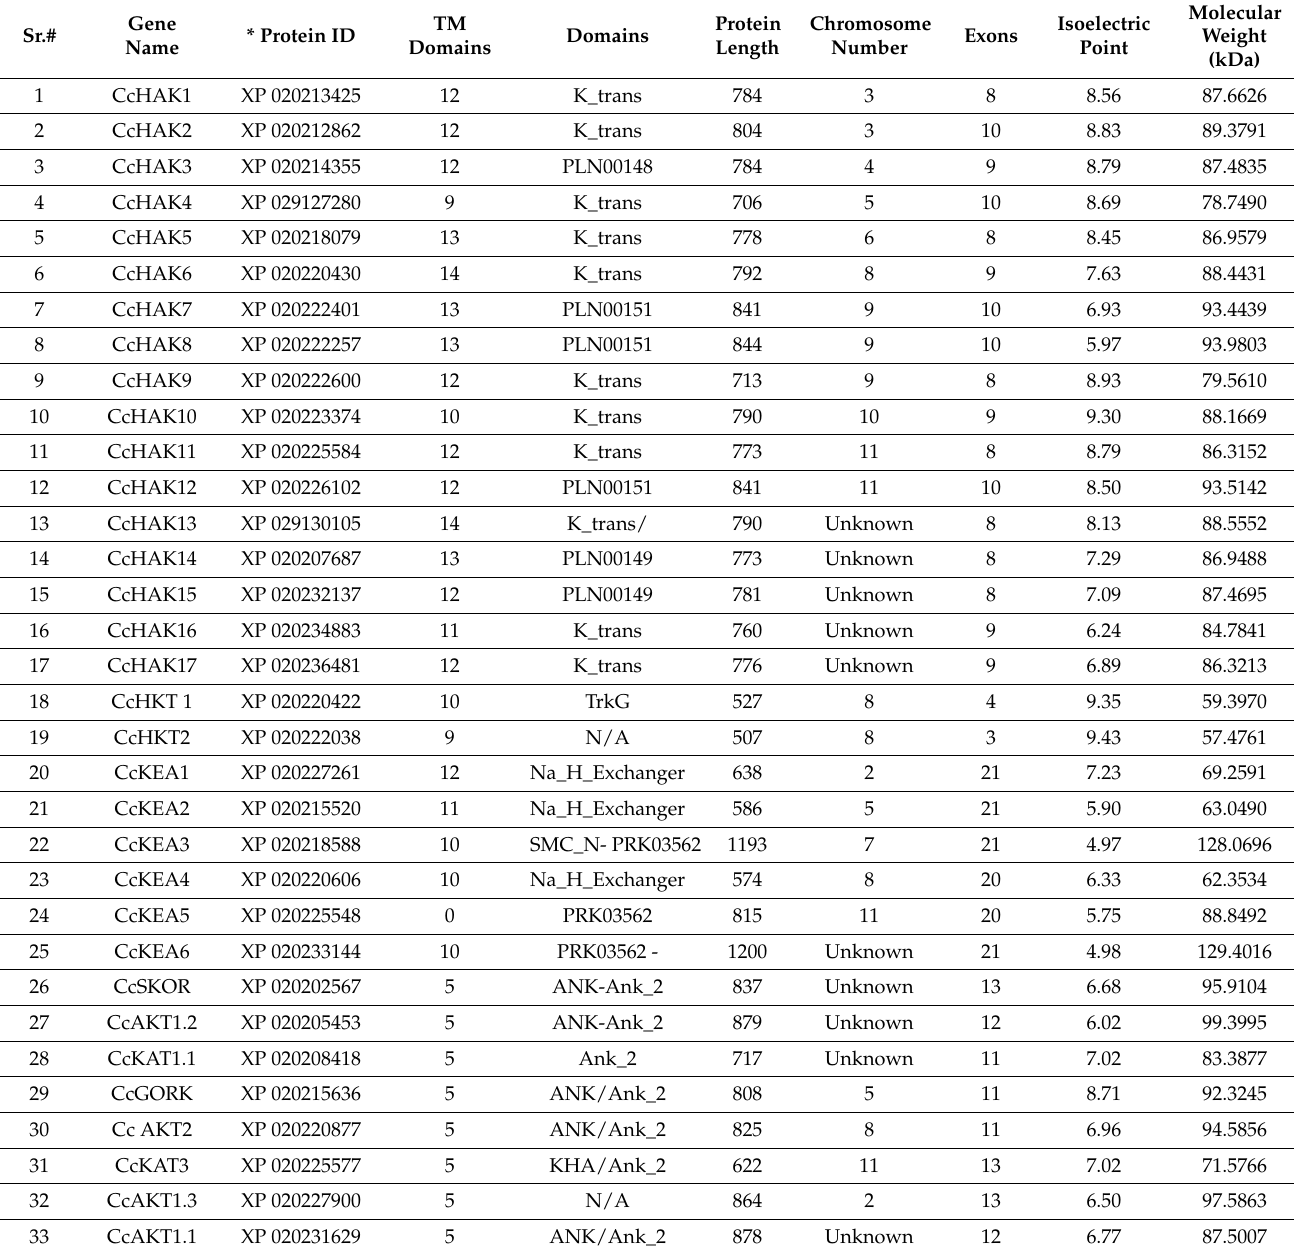
Table 1. Nomenclature and properties of K + channels and transporters in C. cajan